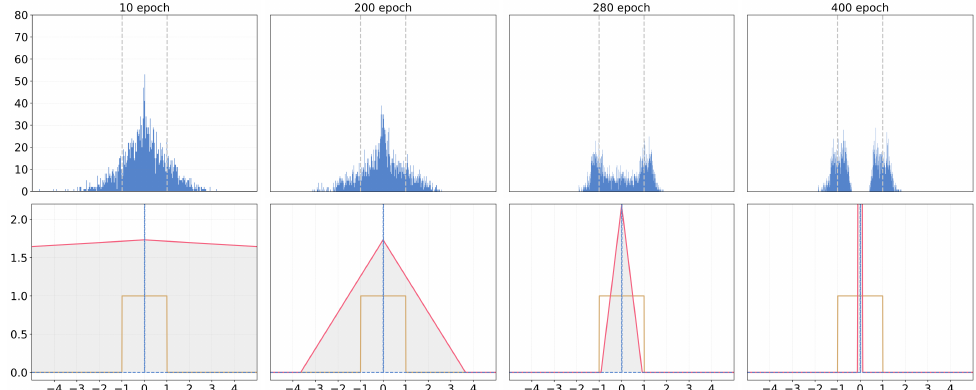
Figure 8. Visualization of the weight (after balance and standardization) distributions and derivatives of IEE in different training epochs (10, 200, 280, and 400). The first row demonstrates the distributions, where the gray vertical lines indicate the − 1 and +1 values. The second row demonstrates the corresponding derivative curves, where the red curve is the proposed IEE, the yellow curve is the STE and the blue one is the sign function.